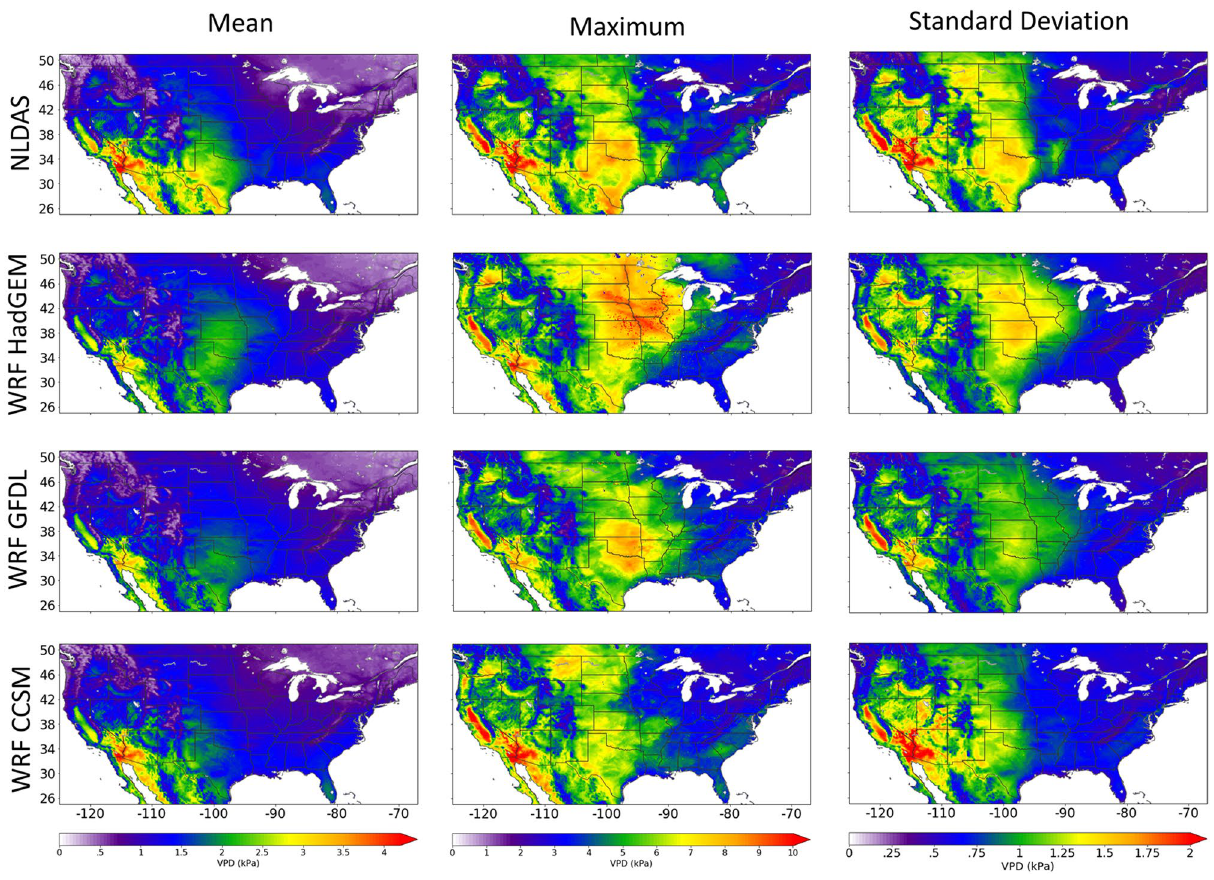
Figure 2. Spatial comparison of VPD statistics for 1995–2004: mean (left column), maximum (middle column), and standard deviation (right column). VPD is calculated with NLDAS (top row) and WRF HadGEM (2nd row), WRF GFDL (3rd row) and WRF CCSM (4th row). This figure was generated using the Matplotlib 41 library for the Python programming language (https:// matpl otlib.